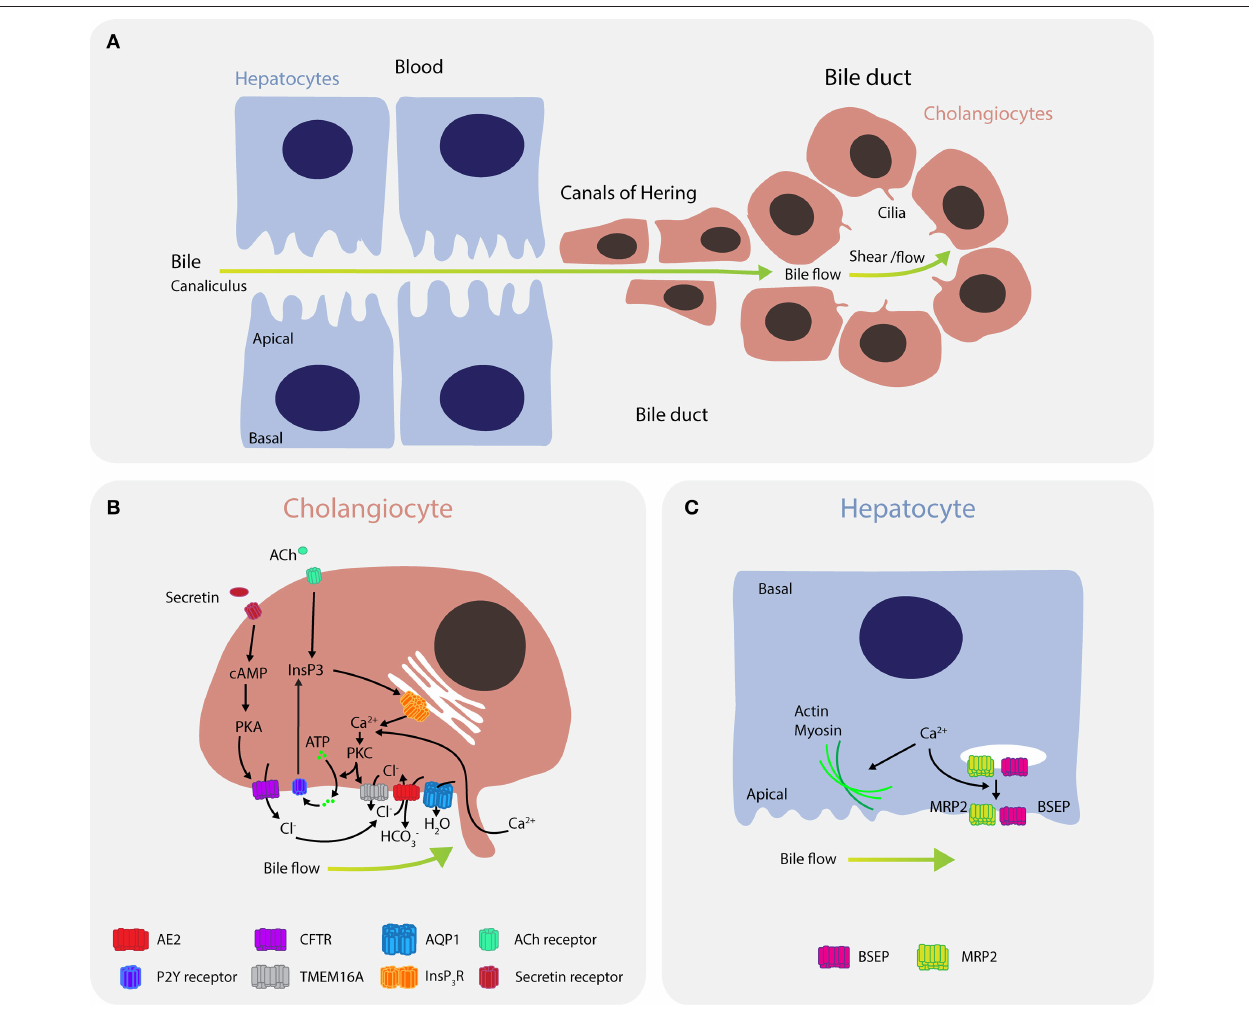
FIGURE 4 | Calcium signaling regulates bile flow in hepatocytes and cholangiocytes. (A) Bile is secreted by hepatocytes into the canaliculus where it is transported to canals of Hering and then into bile ducts. (B) In cholangiocytes, calcium is predominantly released through the type III isoform InsP3R channels (ITPR3) in response to signaling via M3 muscarinic acetylcholine receptors (CHMR3) and purinergic receptors P2. Furthermore, mechanical cues, such as bile flow and shear stress, induce calcium uptake from the bile through ion channels in the mechanosensory primary cilium. Bicarbonate (HCO − 3 ) exchange through the anion exchange protein 2 (AE2) depends on extracellular chloride concentrations (Cl − ), which are regulated by TMEM16A and CFTR. Calcium activates the chloride channel TMEM16A to mediate chloride-bicarbonate exchange at the apical side, while CFTR signaling is activated when secretin binds the secretin receptor on the basolateral membrane, leading to formation of cAMP, activation of PKA and efflux of chloride through the phosphorylated CFTR. Downregulation of ITPR3 in cholestasis, which severely disrupts calcium signaling in cholangiocytes, is thought to be a key mechanism determining bile flow and pathology. Dysregulation of calcium signaling affects multiple pathways regulating both secretion and bile flow. (C) In hepatocytes, calcium is affected by ATP, angiotensin II, vasopressin, glucagon, or epinephrine, and regulates actin-myosin contractility to control peristaltic contractions, as well as exocytic insertion of the bile salt export pump (BSEP) and the multidrug resistance-associated protein 2